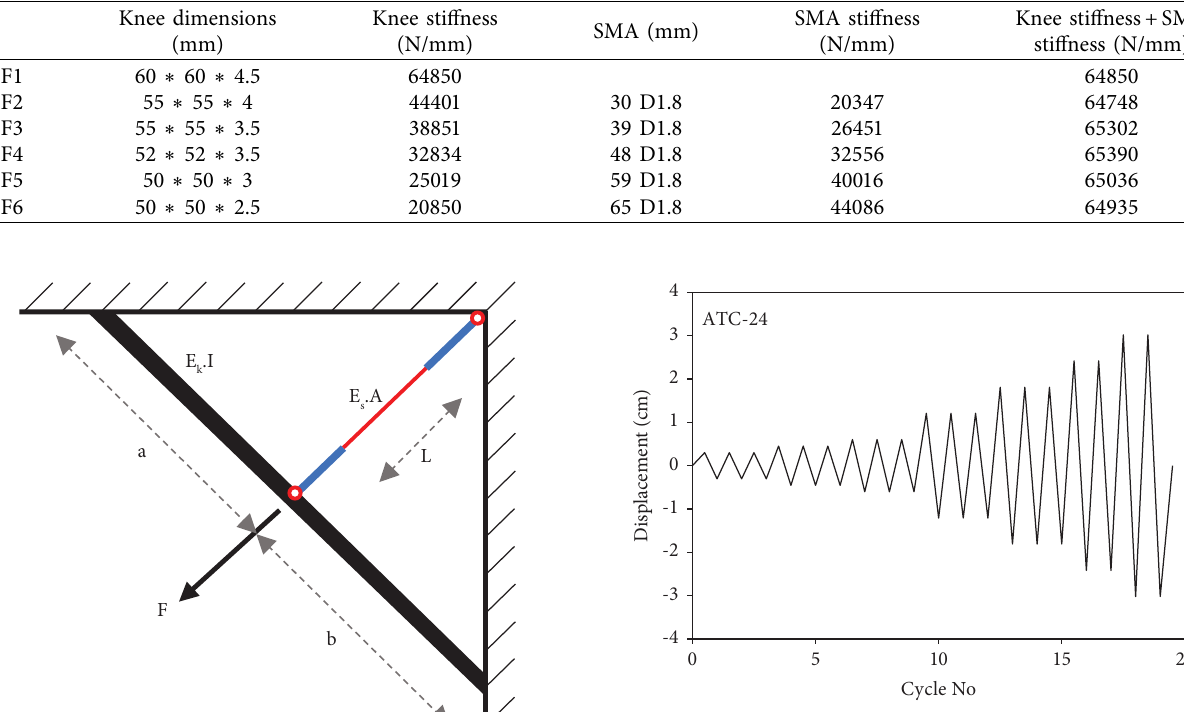
Figure 15: Te system-applied loading